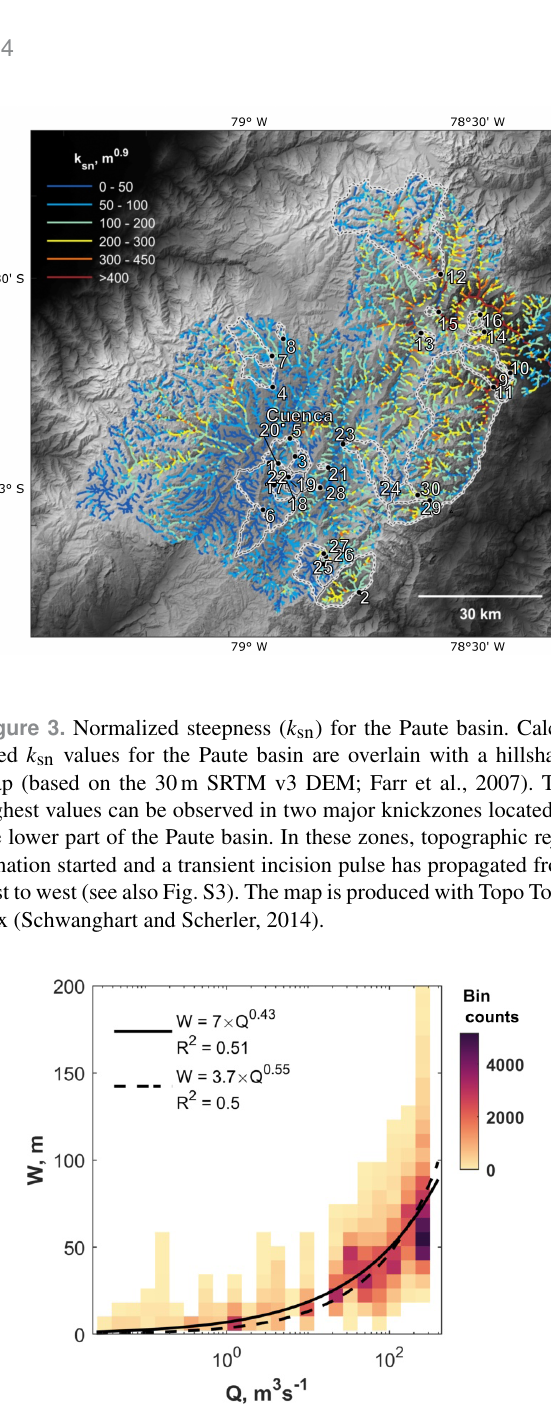
Figure 4. River width ( W ) as a function of the mean annual discharge ( Q ). W represents bankfull channel width for a se- lected number of river sections. These were digitized in Google Earth using the ChanGeom toolset (Fisher et al., 2013; Fig. S5). Mean annual water discharges ( Q ) were derived from the down- scaled R RIDW WRR2 WaterGAP3 data (available from http://www. earth2observe.eu; see Sect. 2.4).